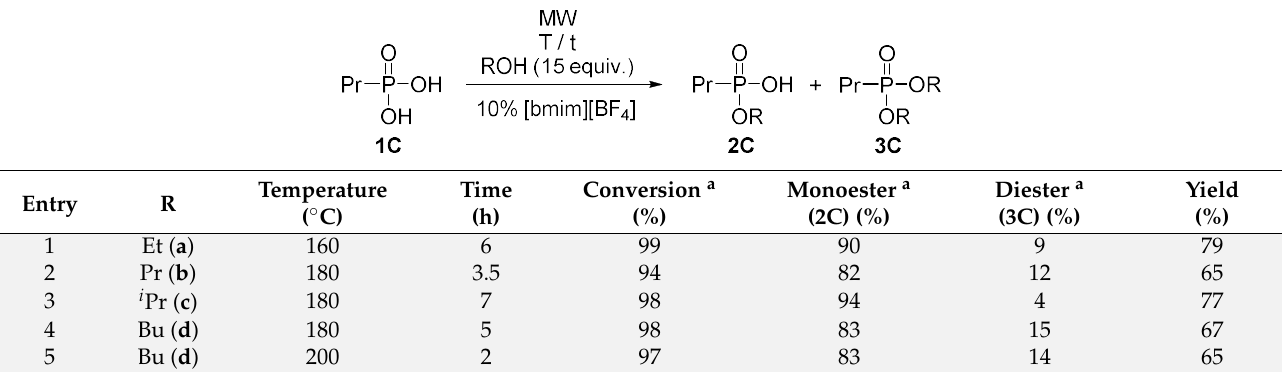
Table 3. Reaction of propylphosphonic acid ( 1C ) in the presence of [bmim][BF 4 ] on MW irradiation.